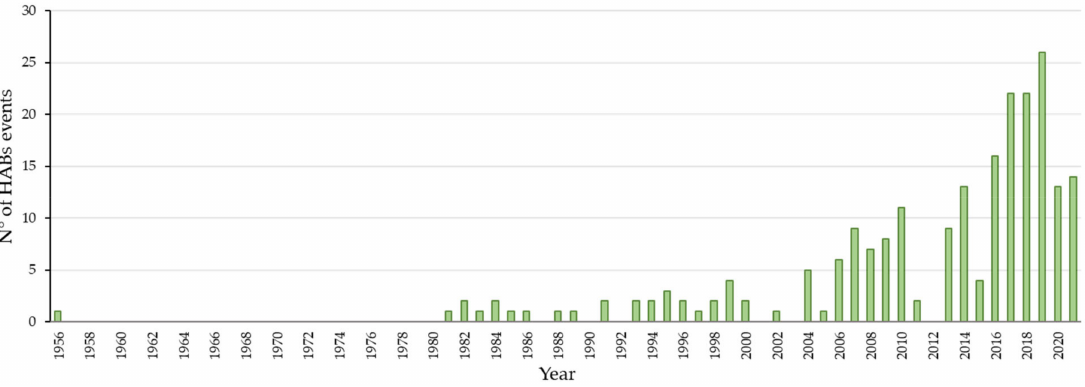
Figure 16. Distribution of HABs events associated with fish mortality and other marine organisms per year in